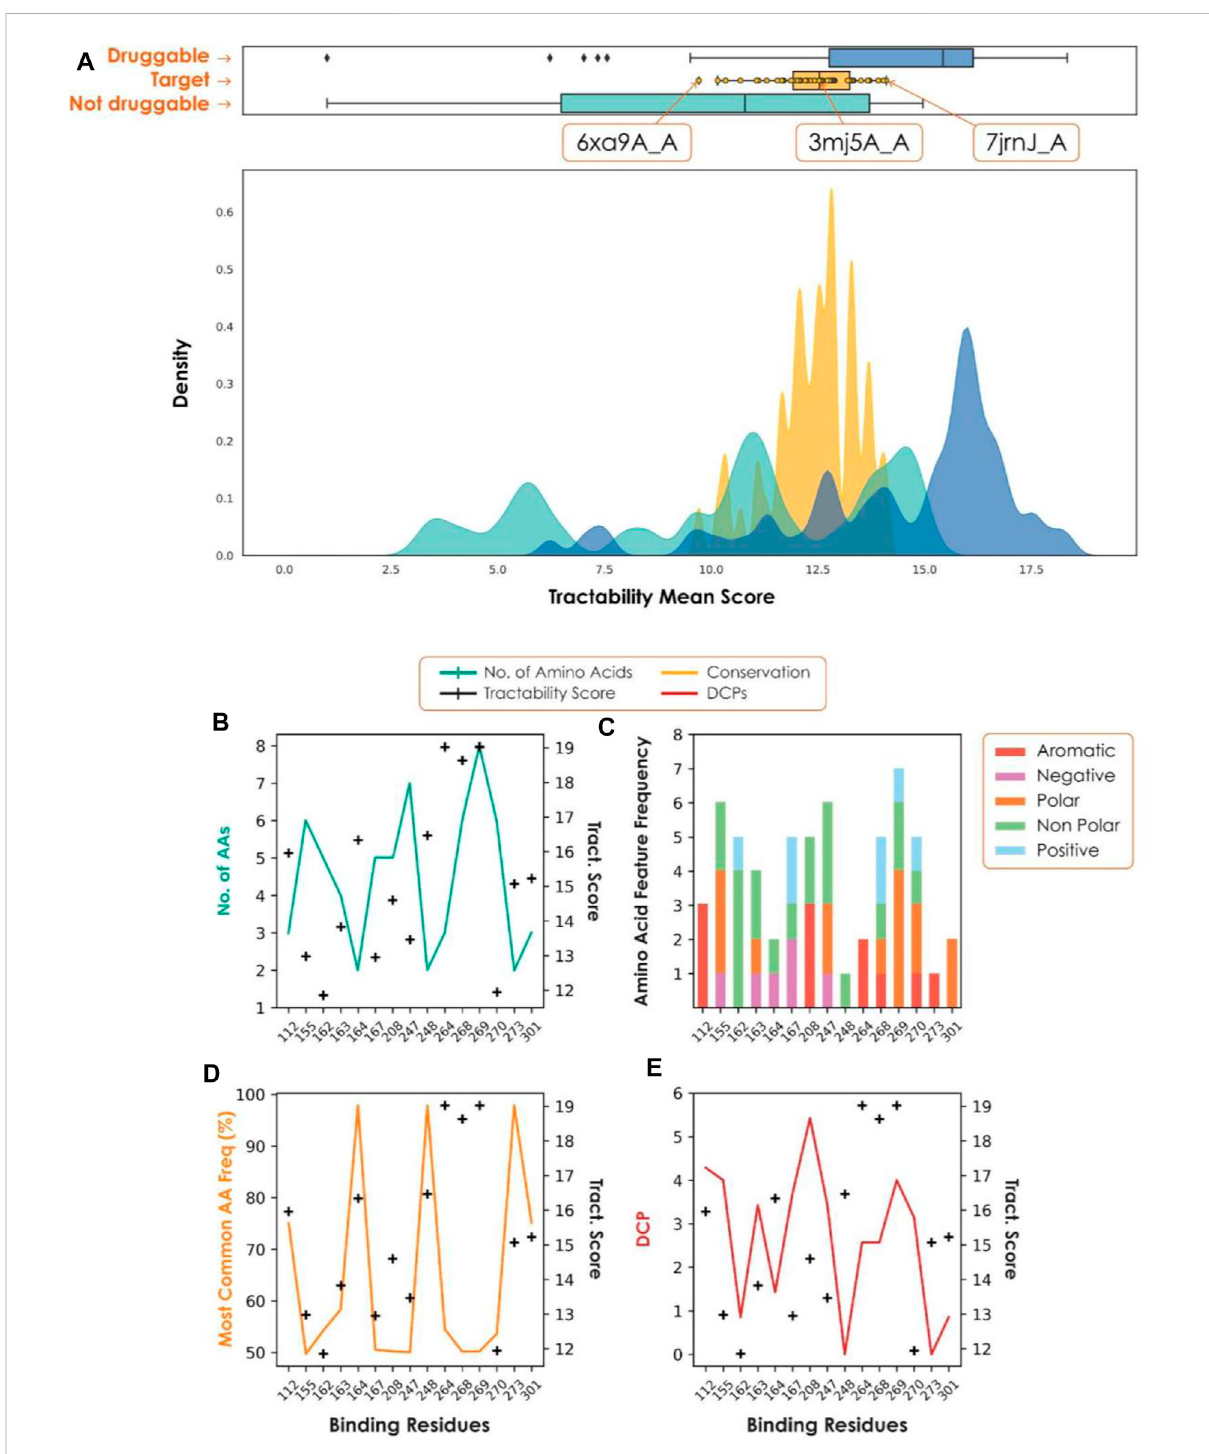
FIGURE 3 (A) Tractability for PLpro (yellow) vs. known druggable (blue) and non-druggable (green) targets. (B – E) Plots to show conservation metrics across coronavirus species HKU1, 229E, OC43, NL63, MERS, SARS-CoV-2 and SARS-CoV. In each plot, the hotspot tractability score for a given residue is shown as a black cross. (B) Number of different amino acids. (C) Number of amino acid properties. (D) Frequency of the most common aminoacid observed. (E) Frequency withwhichanaminoacid isdifferentiallyconserved between speciesfor eachpredictedhotspotresidue.A position is considered differentially conserved when it is conserved within a given species (JS-divergence score > 0.8) and different from a corresponding conserved position in a different species. As we consider multiple species, this plot shows the average number of times a given position is labelled as differentially